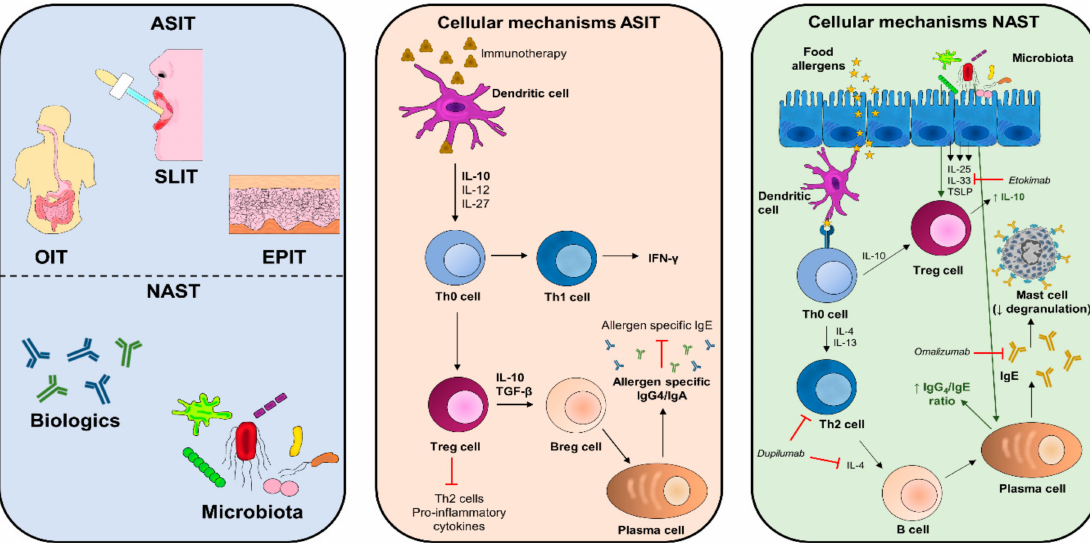
Figure 2. Cellular mechanisms involved in allergen-specific immunotherapy (ASIT) and non-allergen-specific therapy (NAIT). Different therapies exist in the ASIT, such as OIT, SLIT, and EPIT, and in the NAST such as biologics and microbiota. The cellular mechanism in the ASIT implies low doses of food allergen favoring regulatory responses, with Treg cell proliferation, an immunosuppressive Th2 cytokine production, and an immune activation of the Th1 cytokine production to restore the Th1/Th2 balance. All this decreases the production of allergen-sIgE. On the other hand, NAST using biologics directly blocks IgE (omalizumab) or cytokines involved in the Th2 response (dupilumab and etokimab), avoiding cell signaling and all underlying processes involved in FA. In the same way, microbiota acts on the Treg cells by favoring the release of immunosuppressive cytokines (IL-10) as well as plasma cells increasing the immunoglobulin G (IgG) 4 /IgE